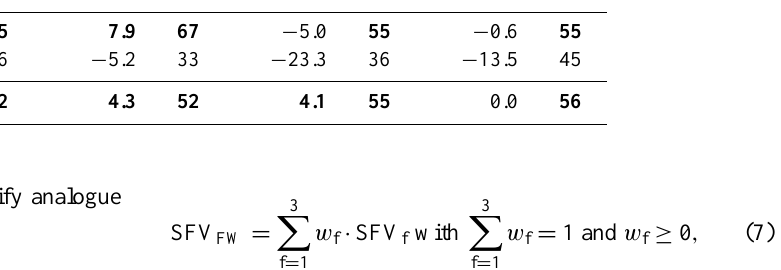
Table 3. Relative improvement RI (%) and frequency of years with a better performance FY + (%) for the median and weighted multi-method approaches, as compared with the climatological ensemble CE (boldface indicates better performance than CE). Median Weighted NEW OPE NEW OPE RI FY + RI FY + RI FY + 1/1 Sorsele 20.9